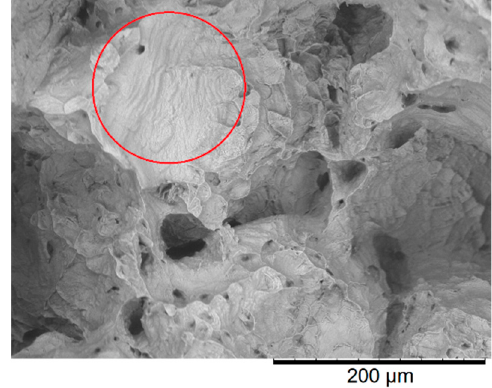
Figure 14. SEM micrograph of the fracture surface of Widmanstätten plasma-nitrided Ti-6Al-4V alloy after creep test at 700 °C and 319 MPa.